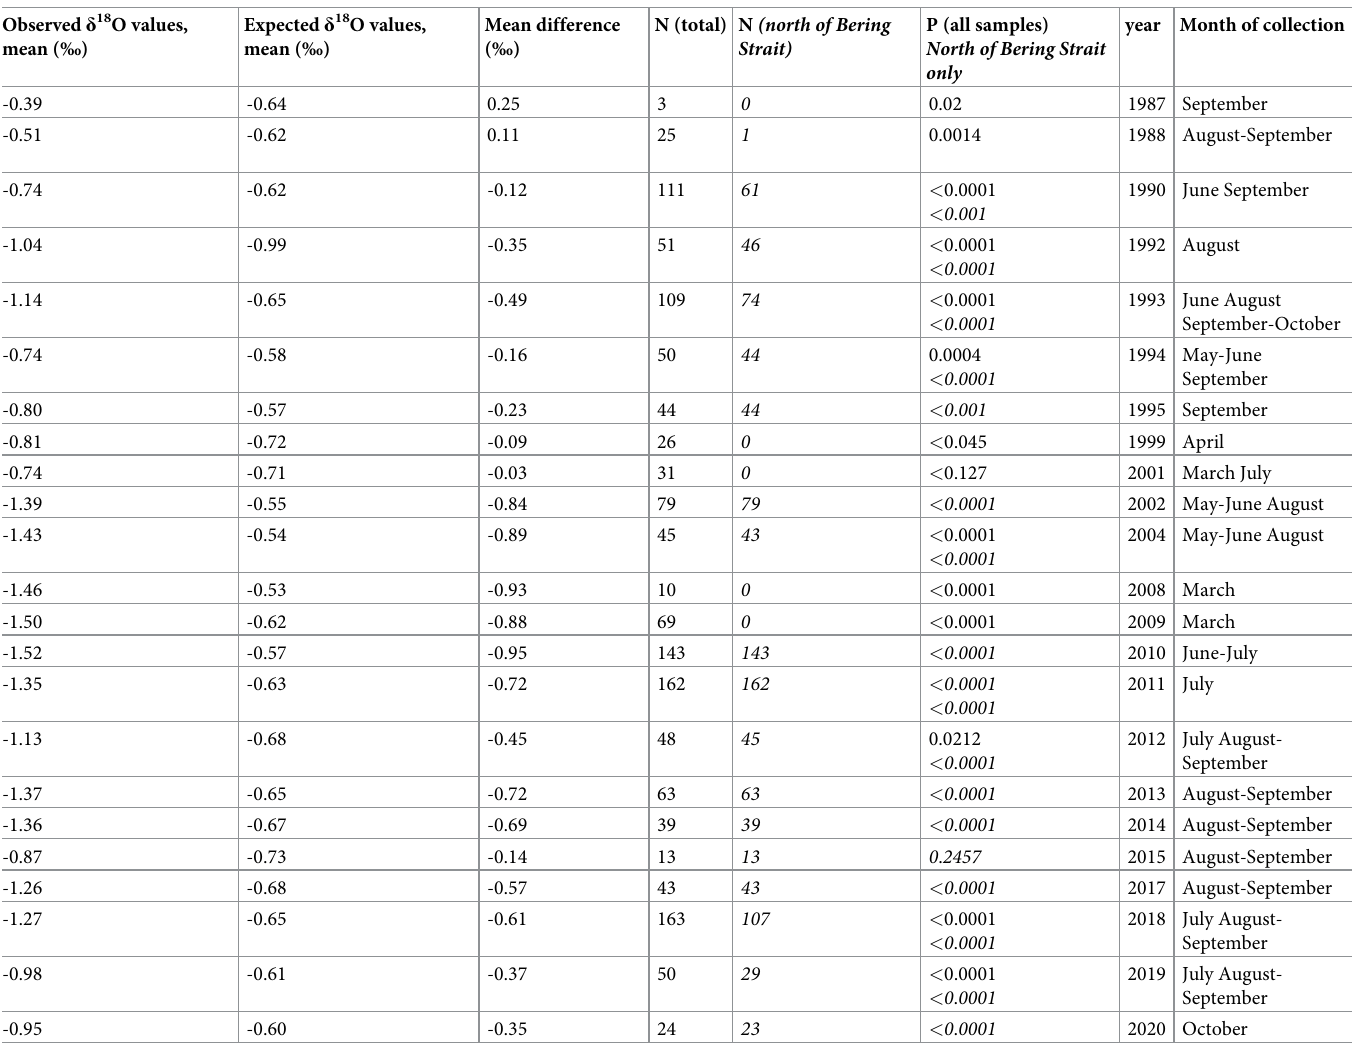
Table 1. Matched pairs differences between observed δ 18 O values and predicted δ 18 O values from Eq (3), sorted by year. P is probability of the null hypothesis being true; there is no significant difference between the observed and expected δ 18 O values. P values and N (sample number) in italics are samples collected north of Bering